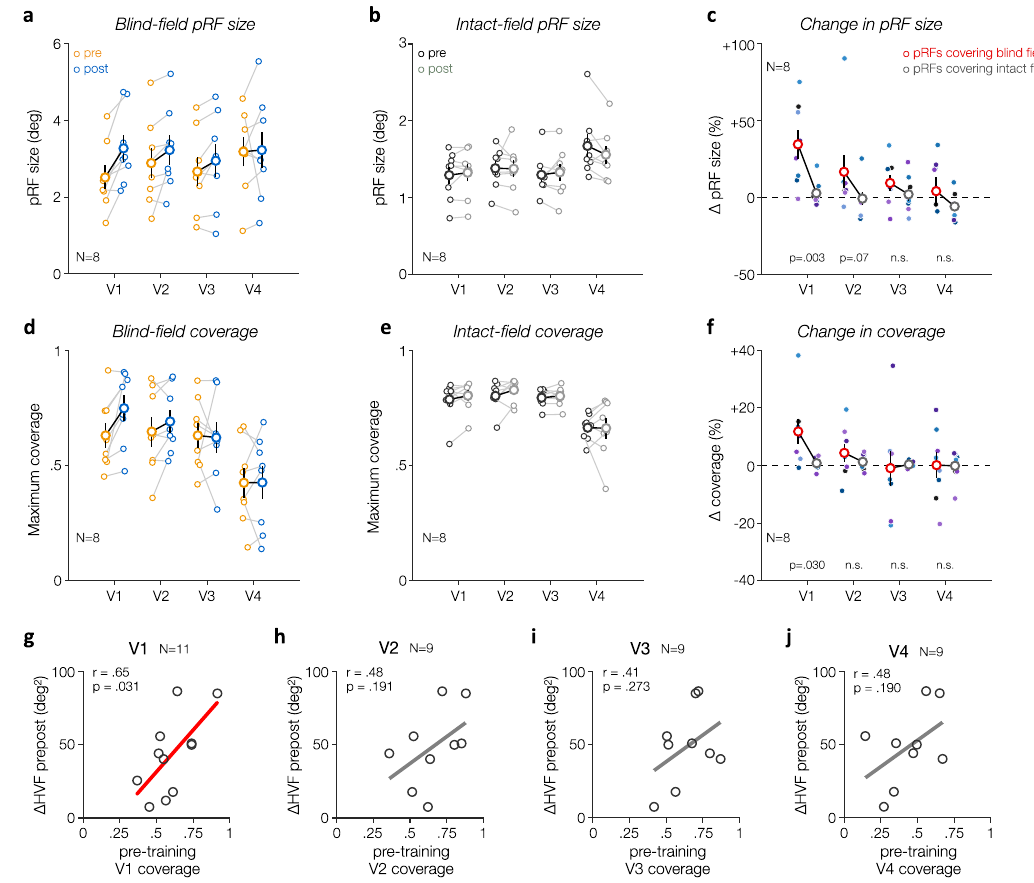
Fig. 8 Lesion-induced and training-induced differences in pRF size and coverage in V1 but not in extrastriate areas (V2, V3, V4). a V1 pRFs covering blind- fi eld regions showed an increase in pRF size following training, which was not observed in extrastriate areas (V2-V4), or for ( b ) pRFs covering solely intact- fi eld regions. c Summary of the changes in pRF size as a function of visual areas and whether pRFs covered blind- fi eld or intact- fi eld regions, computed as a percent change. d , e Training-induced enlargement of V1 pRFs covering regions of the blind fi eld signi fi cantly increases coverage of the blind fi eld in V1, without clear change in extrastriate areas (V2-V4) or for the coverage of the intact fi eld. In panels a-f, small symbols correspond to individual CB patients ( N = 8), with larger symbols corresponding to group-average values (±1SEM). Statistical values for the training*HVF coverage interaction are provided at the bottom of ( c ) and ( f ). g – i Pre-training pRF coverage of the blind fi eld was predictive of the amount of HVF change in V1, but not in extrastriate areas. Note that extrastriate areas could not be de fi ned in two patients (CB9 and CB11), resulting in a different number of patients for extrastriate areas ( N = 9) than for V1 ( N = 11) in panels g-j (excluding these two patients from V1 analyses as well did not affect our fi